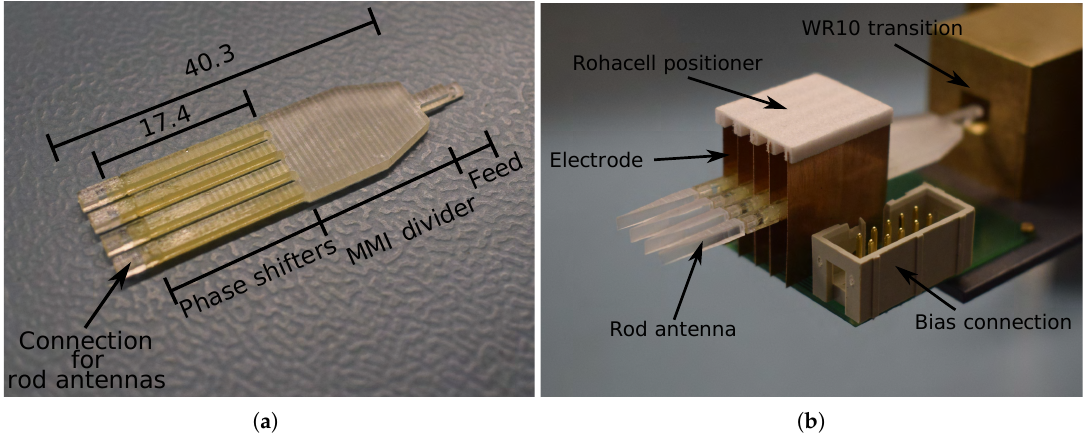
Figure 36. ( a ) Array body milled from one piece with filled and sealed LC phase shifters, ( b ) fully assembled demonstrator with bias electrodes, rod antennas and a transition from WR-10 to dielectric waveguide. Dimensions given in